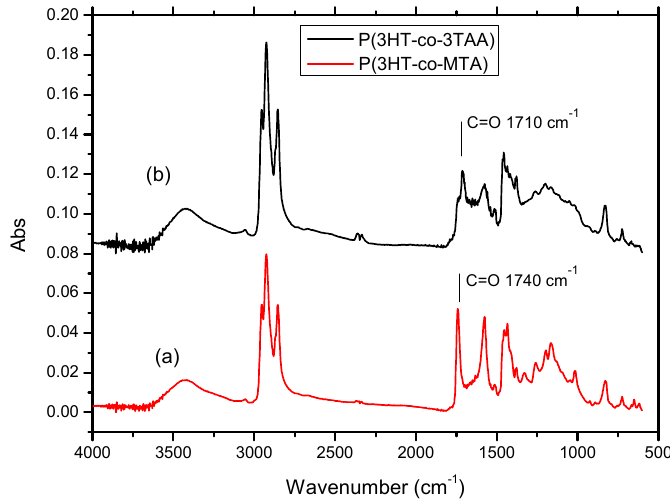
Figure 2. FT-IR spectra of copolymers ( a ) P(3HT- co -MTA); ( b ) P(3HT- co -3TAA).